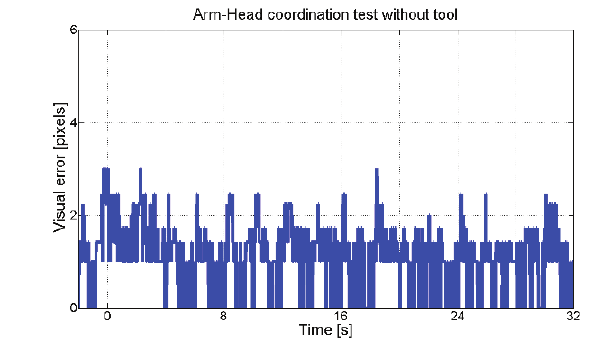
Figure 17. End-e(cid:636)ectorvisualpositionerrorwithrespecttotimeduringthearm- head coordination test performed without the tool. The norm of the (cid:13) (cid:13) (cid:13) x d (cid:13) ) is shown. visual error ( v − x v